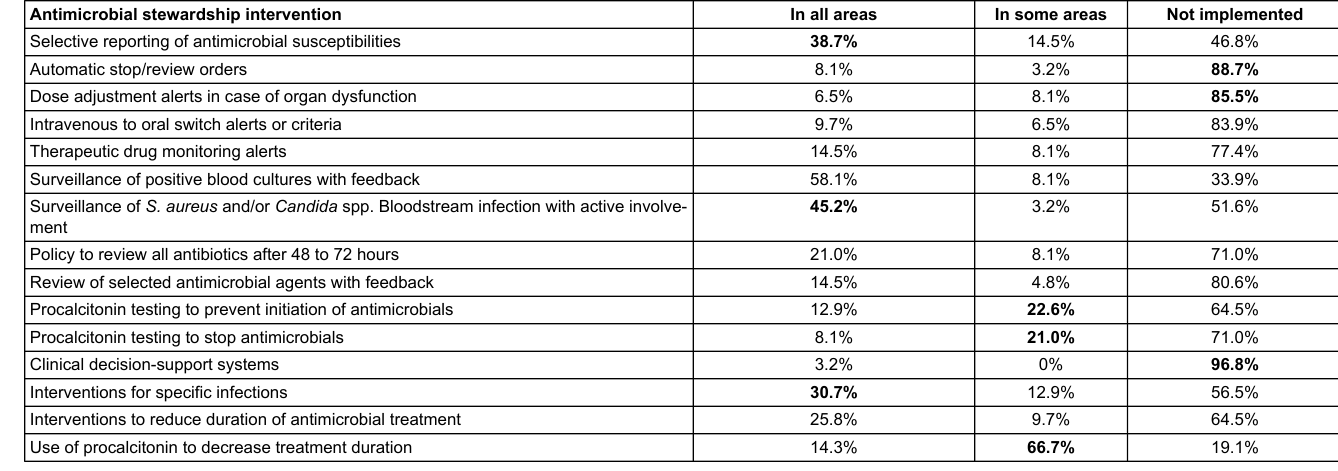
Table 3: Antimicrobial stewardship interventions implemented in the hospitals surveyed (n = 62; answers from one single hospital missing). Antimicrobial stewardship